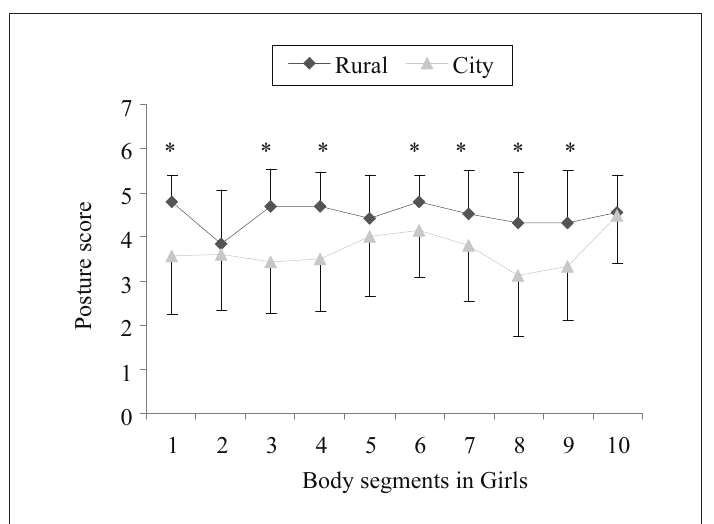
Figure 2. Alignment of different body segments in rural and city girls